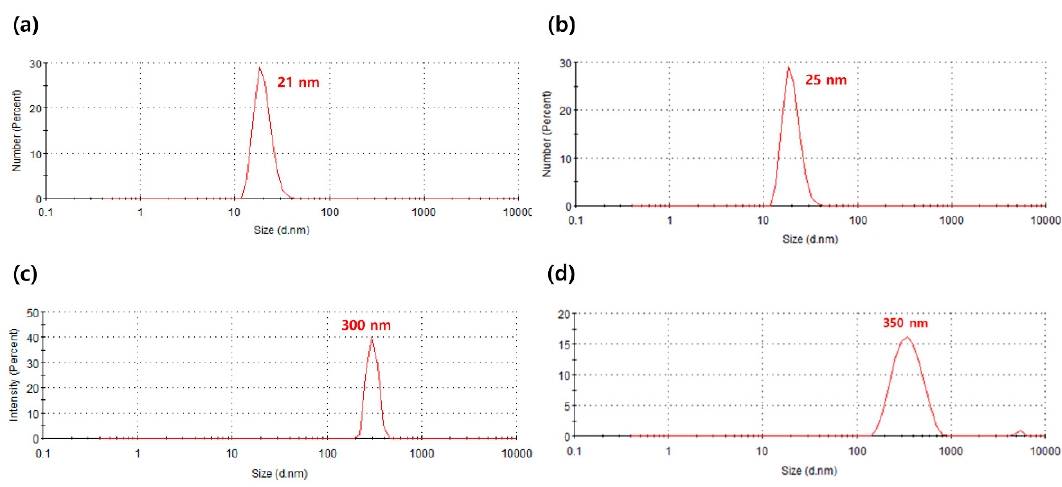
Figure 2. Particle size distribution curves of the pure TiO 2 nanoparticles (( a ) and ( c )) and the synthesized TiO 2 /PMMA hybrid nanoparticles (( b ) and ( d )) with different particle sizes. Table 1. Characteristics of the pure TiO 2 nanoparticles and the TiO 2 / PMMA hybrid nanoparticles. No. Code Material Average Particle Size Surface Characteristic 1 T1 TiO 2 21 ± 2.7 nm Inorganic 2 TP1 TiO 2 / PMMA 25 ± 3.3 nm Organic 3 T2 TiO 2 300 ± 23.9 nm Inorganic 4 TP2 TiO 2 /PMMA 350 ± 93.2 nm Organic